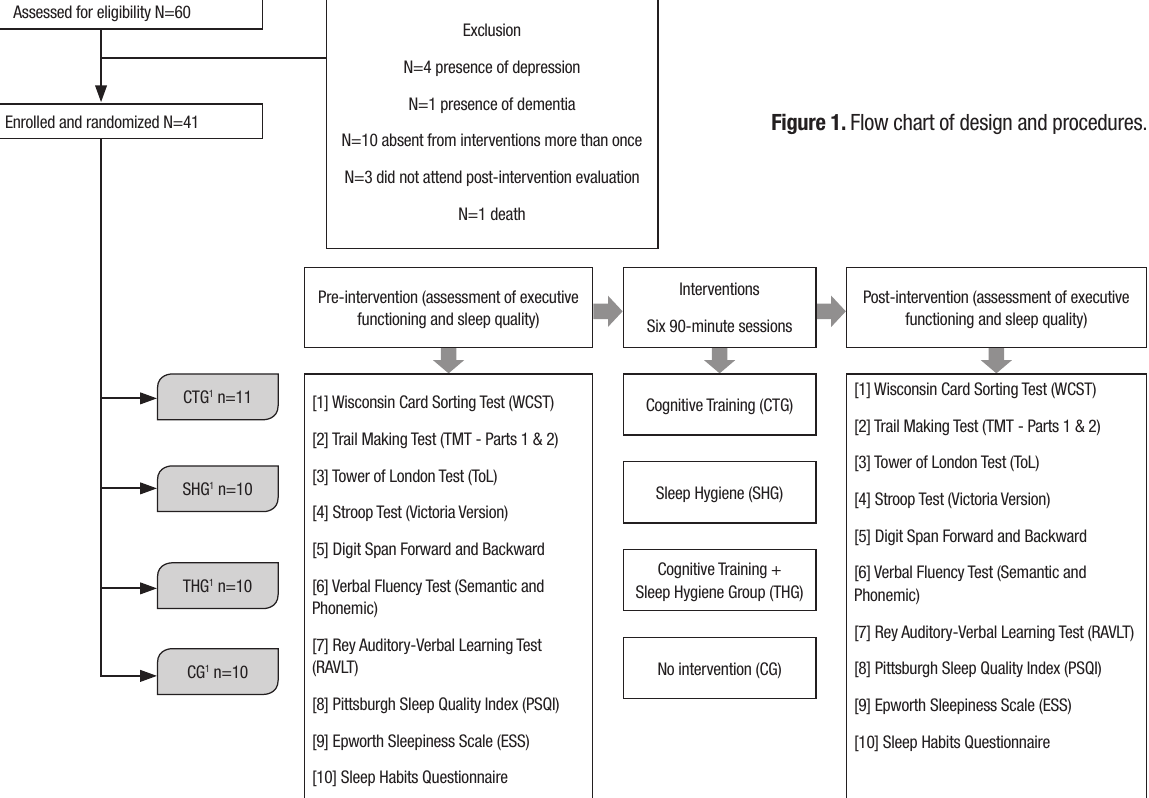
Figure 1. Flow chart of design and